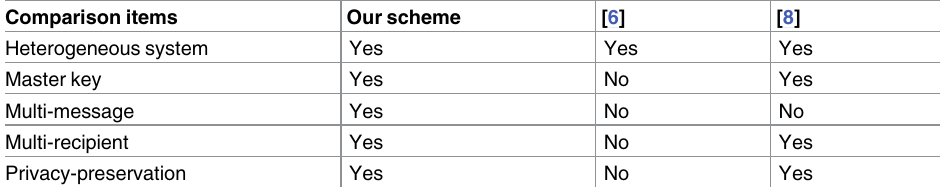
Table 1. Functionality comparison.